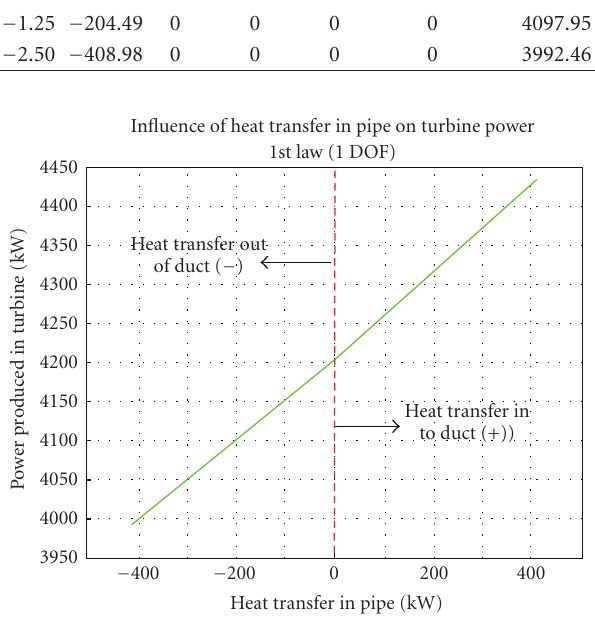
Figure 4: Graphical results for 1 DOF 1st Law Analysis. Increasing heat transfer results in increased turbine